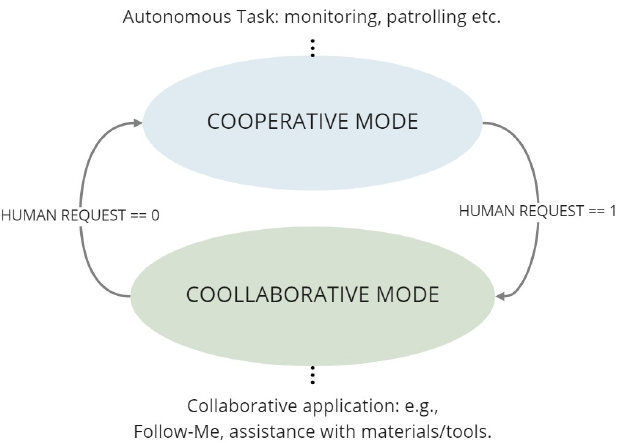
Figure 12. Modes switching schema for a Sen3Bot monitoring an area of type 2, enabled to wait for collaborative task triggering, i.e., with wait4col ==